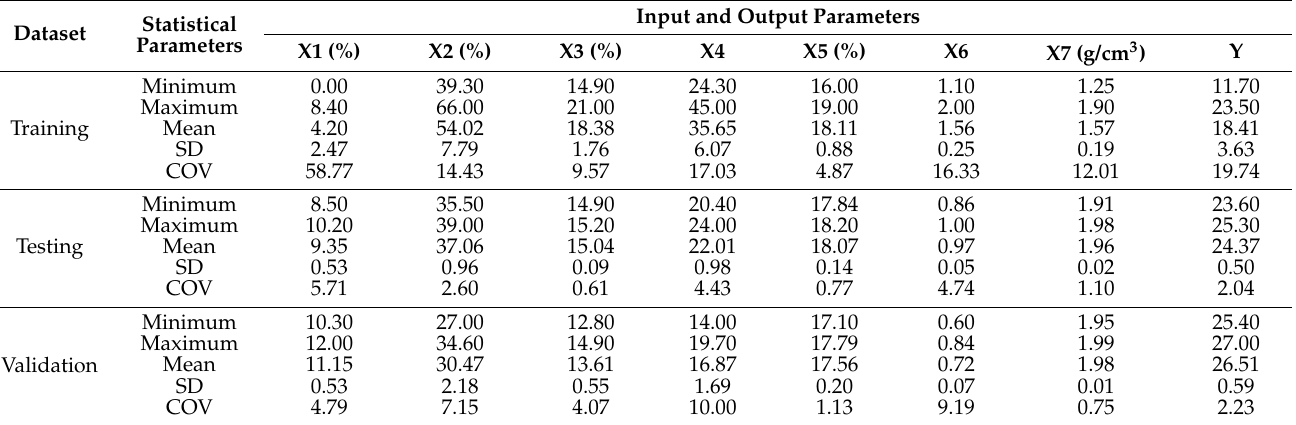
Table 1. Statistical analysis of the input and output